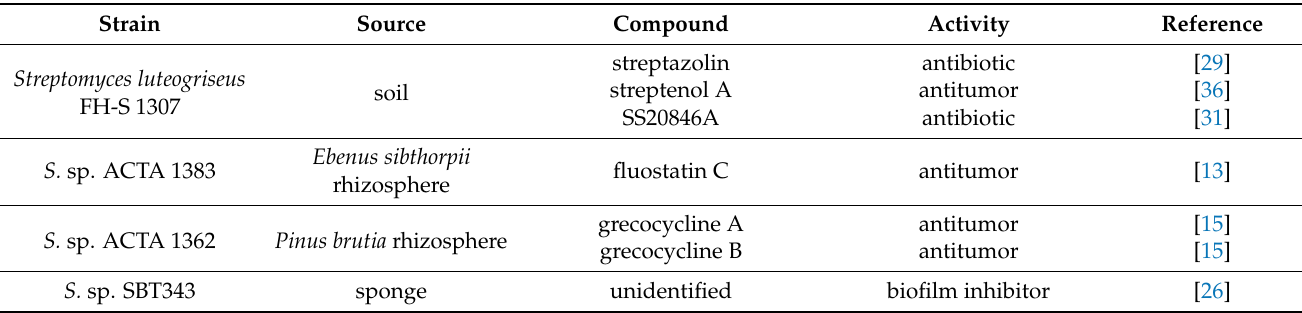
Table 1. Greek Streptomyces isolates, compounds they produce and their activities. The strain S. sp. SBT349 has had its genome sequenced [51] and is available via DSMZ under the number DSM 100667 [59]; the other strains have not had their genomes sequenced and are available via the research organizations that worked on